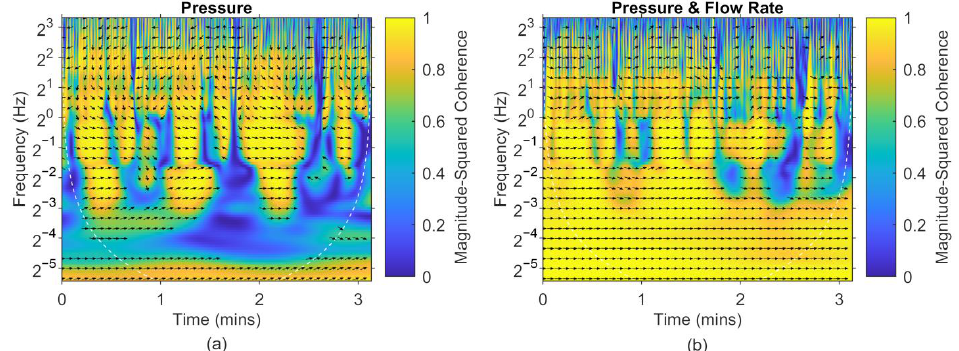
Figure 7. The prediction based on pressure and flow rate improved coherence and phase angle. The magnitude-squared wavelet coherence in the time-frequency plane ( a ) between measured PPG and estimated PPG(P) and ( b ) between measured PPG and estimated PPG(P,Q). The coherence was calculated from a long recording under pulsatile flow with different levels of resistance and mean flow rate. The colormap corresponds to the coherence value. The arrows indicate the phase angle between the two signals, on regions with high (>0.5) coherence. An arrow pointing to the right indicates that the two signals are in phase (0 o ), an arrow pointing to the left indicates that they are in counter-phase (180 o ) and intermediate positions indicate the phase delay. The white dashed line signifies the cone of influence.